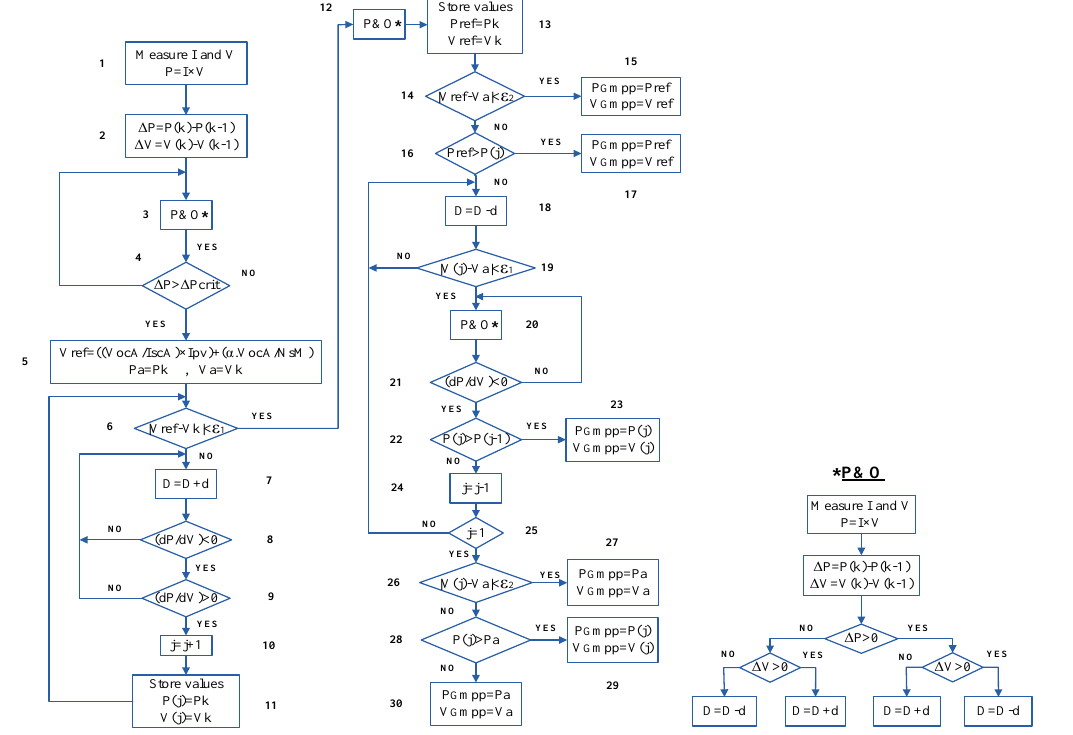
Figure 9. Flowchart of the proposed algorithm.